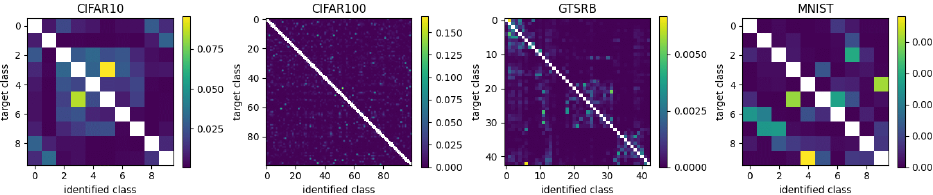
Figure 2. Confusion matrices corresponding to CDN noise generation. The colors correspond to the average confusion probability as observed over 200 epochs of training for all eight DNN architectures.